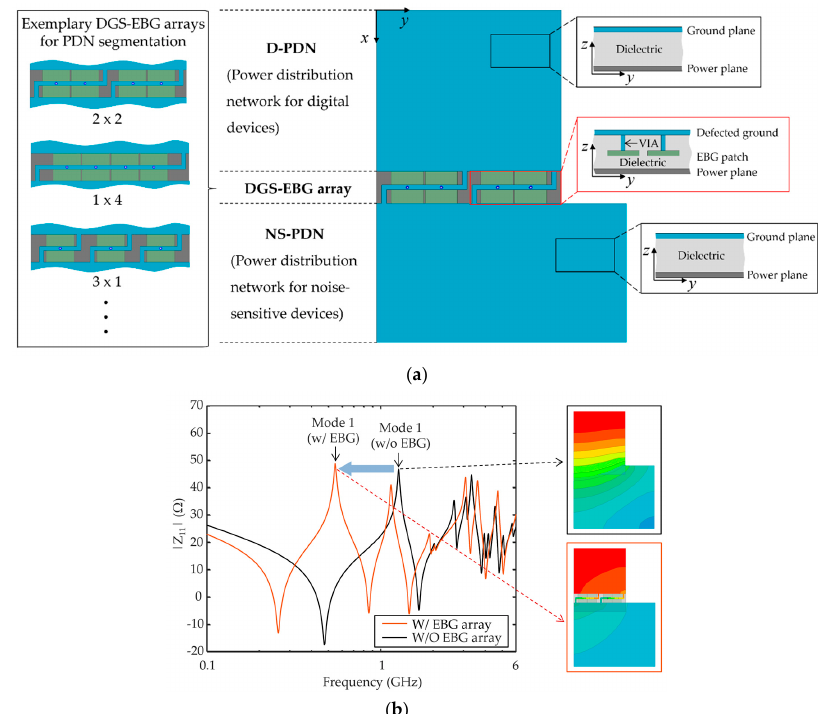
Figure 1. ( a ) Power distribution network (PDN) segmented by the electromagnetic bandgap (EBG) structure with a defected ground structure (DGS) and various configurations of the DGS–EBG array; ( b ) comparison of impedance parameters of the PDNs with and without DGS–EBG array segmentation.